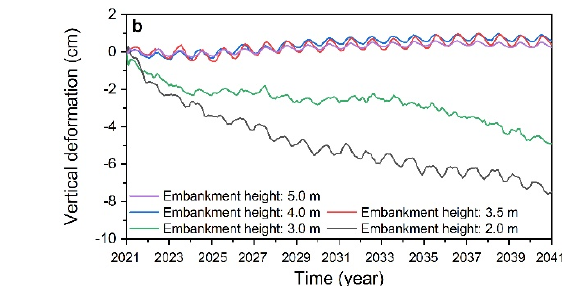
Figure 9. Vertical distributions of volumetric unfrozen water content under the road centerlines of different structures: ( a1 – a4 ) vertical distributions of volumetric unfrozen water content in warm seasons and ( b1 – b4 ) vertical distributions of volumetric unfrozen water content in cold seasons.